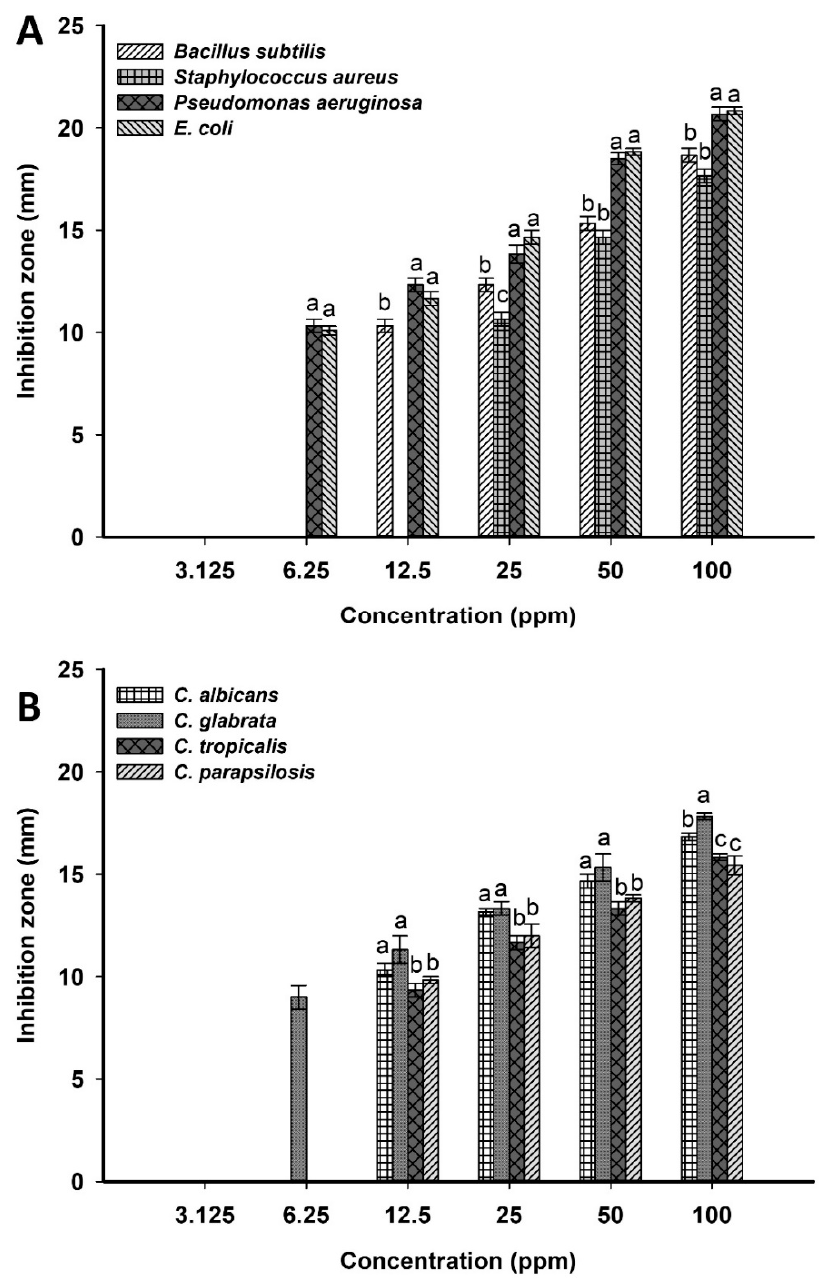
Figure 6. Antimicrobial activity of Ag-NPs synthesized by harnessing the metabolites of A. flavus . ( A ) is antibacterial activity against B. subtilis, S. aureus, P. aeruginosa, and E. coli, ( B ) is anti-candida activity against C. albicans, C. glabrata, C. tropicalis , and C. parapsilosis. Data are statistically different at p ≤ 0.05 by Tukey’s test, ( n = 3); error bars are means ± SD. Different letters at the same concentration indicate the data are significant.